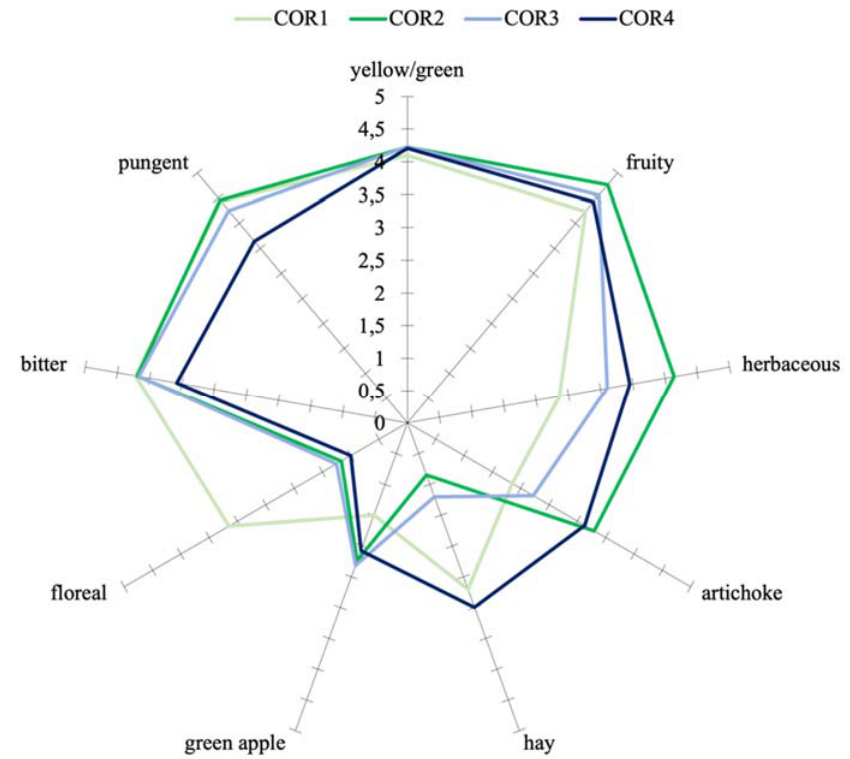
Figure 2. Sensory profile of cv. Coratina olive oil obtained by adding three different concentrations of oxygen (0.2 L/min for COR2, 0.4 L/min for COR3, and 0.8 L/min for COR4) during crushing phase in comparison with control test (no oxygen added for COR1)